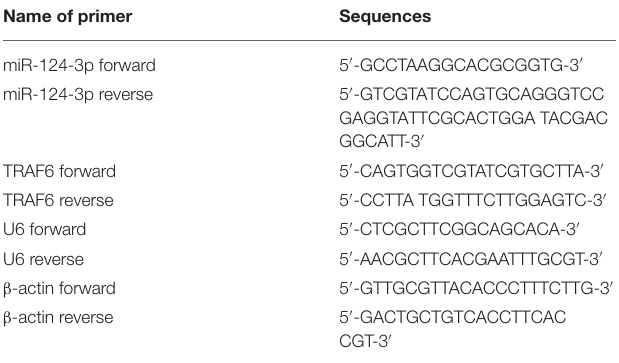
TABLE 2 | Primer sequence for